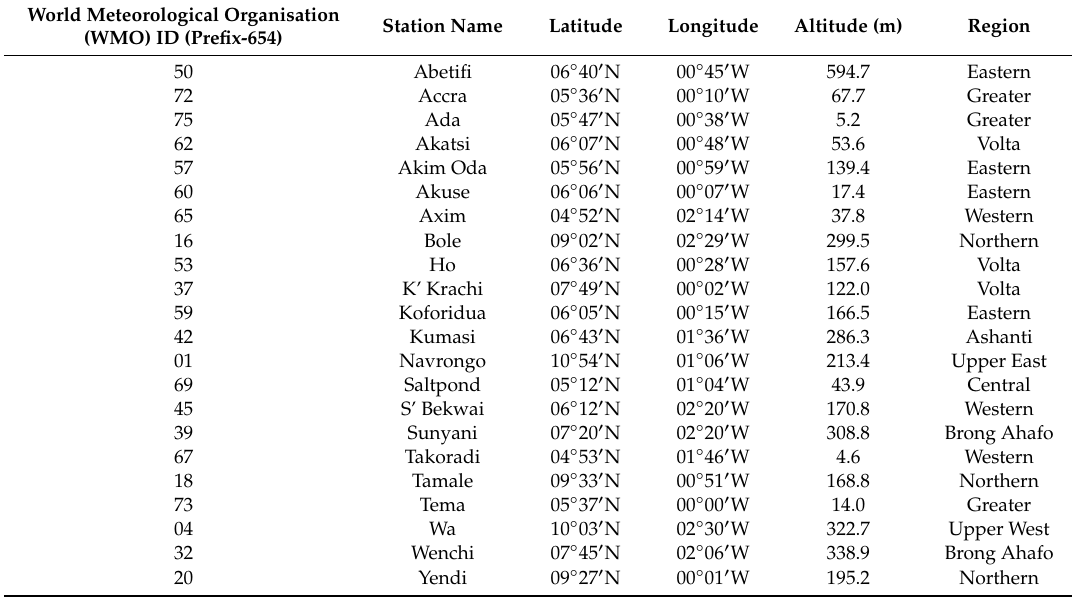
Table 1. ID, station name, location, and elevation of 22 available synoptic GMA stations in Ghana. World Meteorological Organisation (WMO) ID